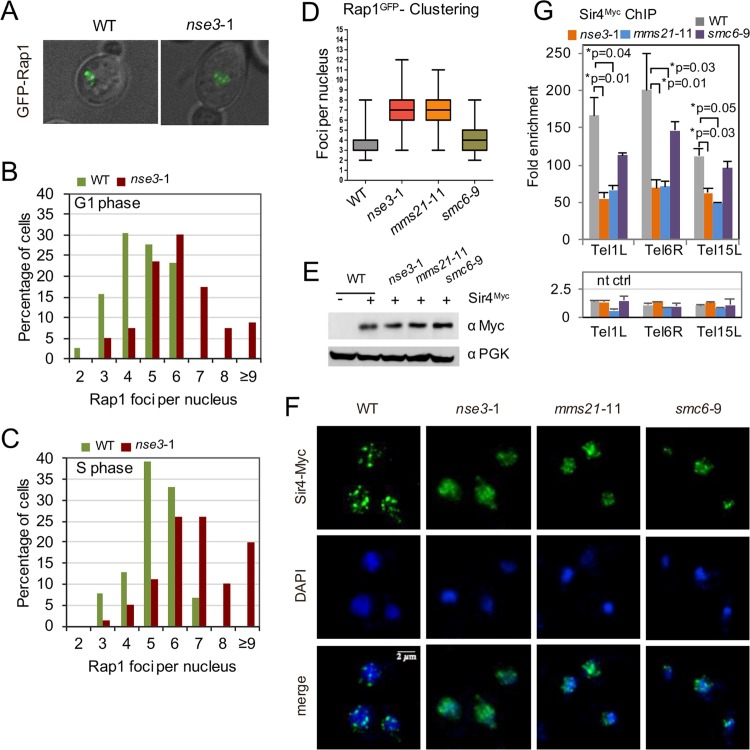
Smc5/6 is critical for telomere clustering and Sir4 binding to telomeres.(A) Rap1-GFP foci in WT (JC1822) and nse3-1 (JC3041) cells counted as a measurement for telomere clustering with representative merged images of GFP and DIC channels. (B-C) The number of GFP-Rap1 foci was determined for cells within G1 (unbudded) or S (small budded cells) phases in at least 100 cells for each cell cycle stage, and (D) compared with mms21-11 (JC1827) and smc6-9 (JC2710). (E-F) Western blot analysis and immunofluorescence staining using α-Myc antibody (green in IF) to detect Sir4Myc in WT (JC3433), nse3-1 (JC3452), mms21-11 (JC3597), and smc6-9 (JC2907) cells with DAPI staining shown in blue. (G) ChIP was performed on Sir4Myc as in Fig 1E from asynchronous cultures and in more than one isogenic strain if available. The fold enrichment for each strain is calculated for n≥3 experiments with the mean ± SD at three native subtelomeres (Tel1L, Tel6R and Tel15L). The p values < 0.05 from a two-tailed t-test are indicated by (*) for wild type (JC2671 and JC3433), nse3-1 (JC3452 and JC3849), mms21-11 (JC3597), and smc6-9 (JC2907 and JC3087) and non-tagged (nt) control strains included wild type (JC470), nse3-1 (JC3607), mms21-11 (JC1879), and smc6-9 (JC1358).